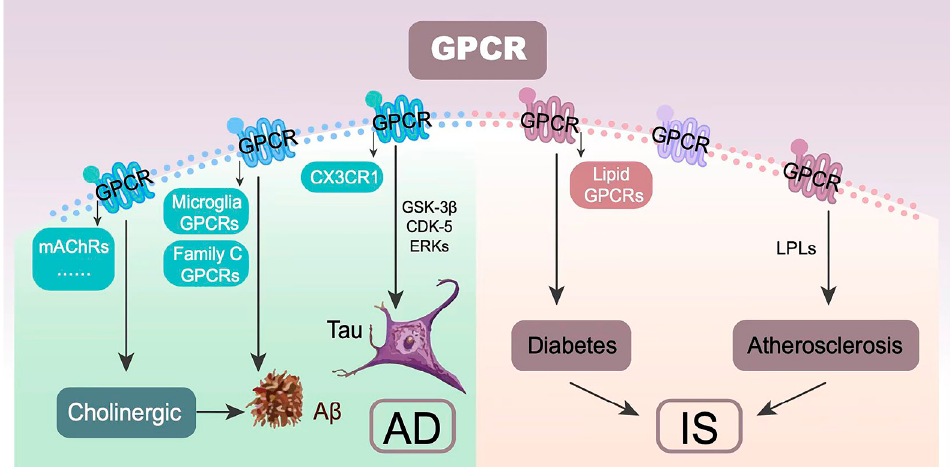
Figure 4. The involvements of GPCRs in AD and IS. Abbreviation: A β : amyloid β ; AD: Alzheimer’s disease; CDK-5: cyclin-dependent kinase-5; CX3CR1: CX3C chemokine receptor 1; ERKs: extracellular signal-regulated kinases; GPCR: G protein-coupled receptor; GSK-3 β : glycogen synthase kinase-3 β ; IS: ischemic stroke; LPL: lysophospholipids; mAchRs: muscarinic acetylcholine receptors.